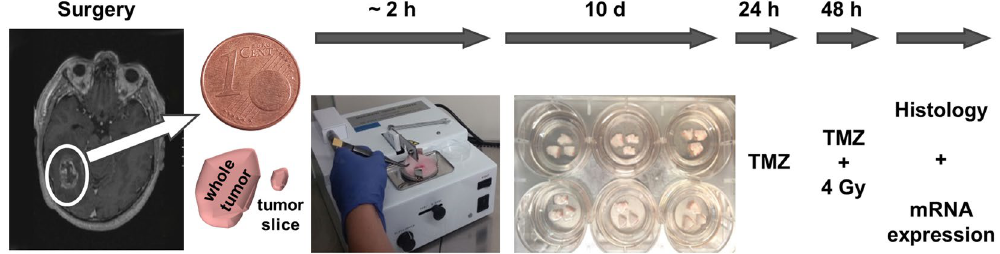
Figure 7. Experimental setup. Freshly resected glioblastoma (zone I) and peritumoral brain tissue (zone III) was transported into the lab in sterile transport medium and stored at 4 °C. The production of 350 µ m tissue slices was performed with a tissue chopper. The slices were separated from each other by the wide opening of a glass pipette and randomly allocated to membrane inserts and put in the wells of sterile 6-well plates, previously filled with 1 ml of cultivation medium. The slices were cultivated 10 days before treatment with radiochemotherapy was implemented. 24 hours prior to irradiation with 4 Gy the slices were pretreated with 200 µ M temozolomide (TMZ). After a total treatment time of 72 hours the slices were either fixed in 4% paraformaldehyde for histological analyses or processed for RNA and protein isolation to perform